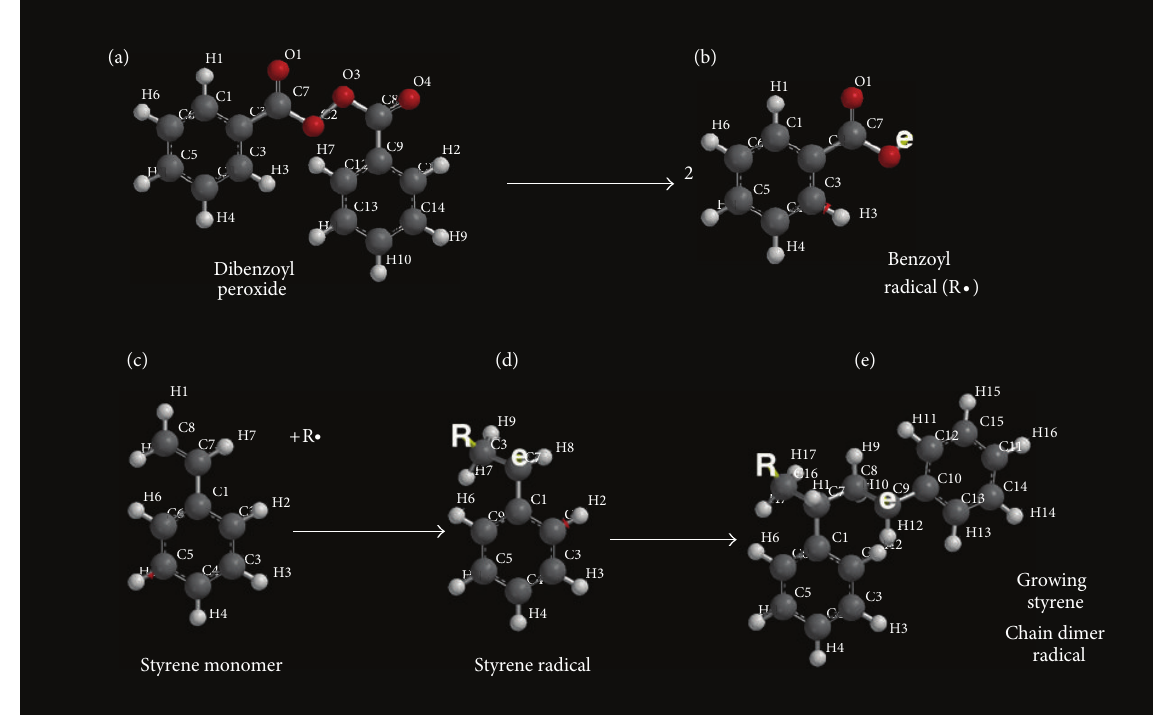
Figure 3: (a) Dibenzoyl peroxide commonly known as benzoyl peroxide or BPO dissociates into two molecules to provide (b) benzoyl free radicals (R ∙ ). (c) In liquid form, styrene monomer with vinyl-group C7 and C8 (C=C) double pi ( 𝜋 ) bond upper left of molecule is attacked by R ∙ to add a benzoyl group on one of the carbon atoms. (d) Subsequent styrene radical formation depicted by “e” on the opposite vinyl carbon atom can now enter into a reaction with a new styrene molecule C=C vinyl group. (e) A second styrene molecule can add the benzoyl-styrene radical on the C=C vinyl group for the growing chain to form a free radical again as “e” on the opposite vinyl carbon atom. Free-radical additions through the liquid styrene monomer C=C vinyl groups continue the polymerization process by the reactive secondary sequence method a multitude of times to eventually form a solid.